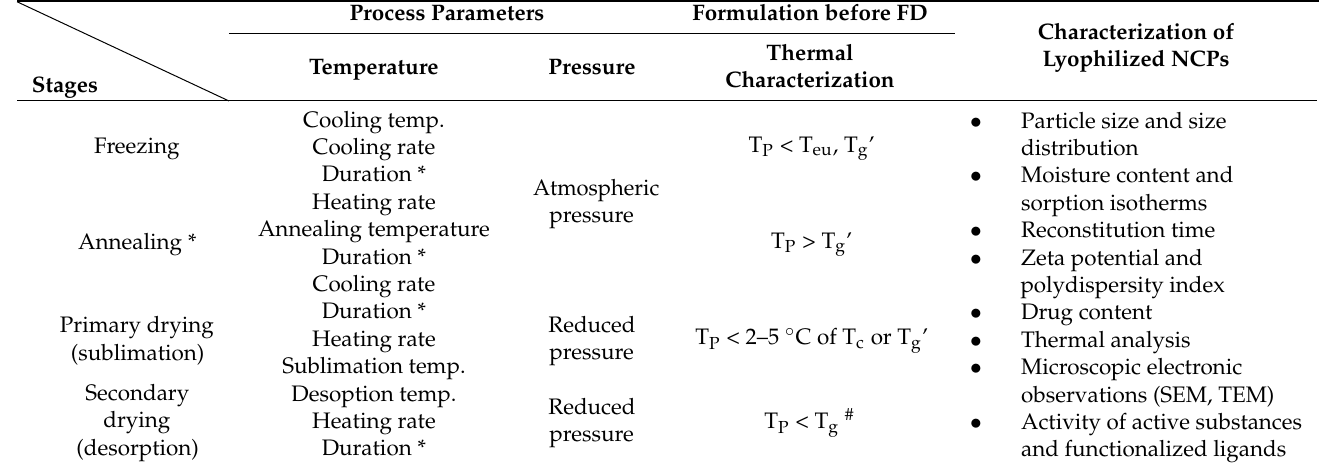
Figure 3. Successive stages in lyophilization: the evolution of the process parameters and the corresponding state of the product to be lyophilized. Table 3. Presentation of the process parameters and the product thermophysical properties at each stage of freeze drying and required characterization techniques for the final dried